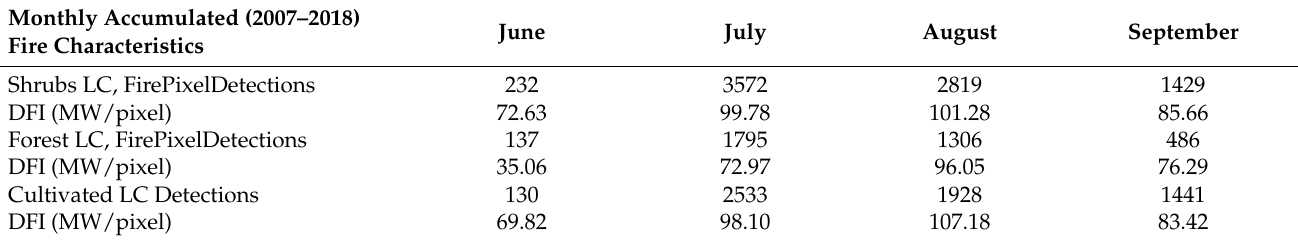
Table 2. Monthly accumulated FRP-Pixel detections for the period of 2007–2018 and the total FRP energy released per pixel (MW), DFI. Examples for shrubs, forest, and cultivated LCs for June, July, August, and September are